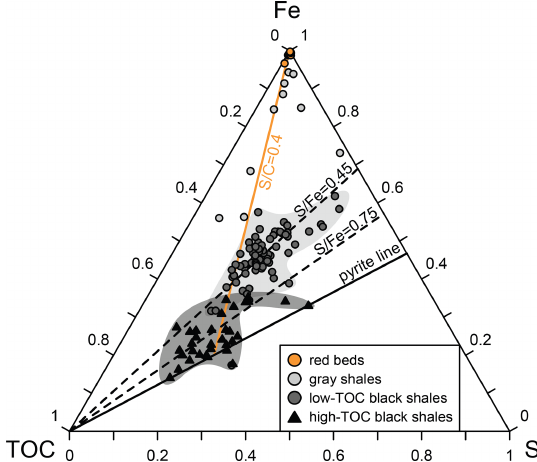
Figure 6. Ternary diagram illustrating TOC, S, and Fe rela- tionships in the different lithostratigraphic (sub)units. Character- istic S / Fe and S / C ratios used to discriminate redox states (i.e., oxic conditions: S / C = 0.4 and S / Fe < 0.45; suboxic–anoxic con- ditions: S / Fe = 0.45–0.75; and strictly anoxic–euxinic conditions: S / Fe > 0.75) are plotted as proposed by Raiswell et al. (1988), Lev- enthal (1983), and Berner and Raiswell (1983). TOC data are taken from Dummann et al.